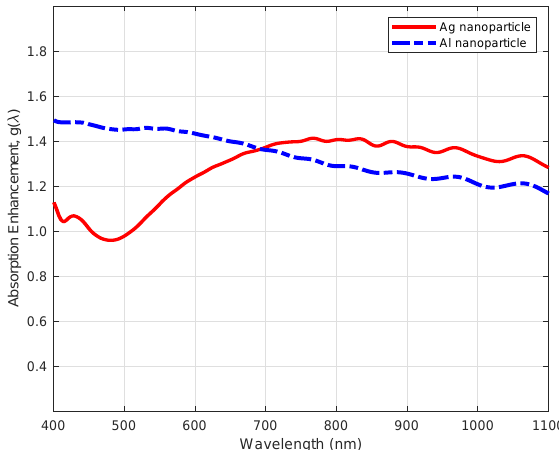
Figure 3. Absorption Enhancement g( λ ) of silicon as a function of wavelength for Ag and Al